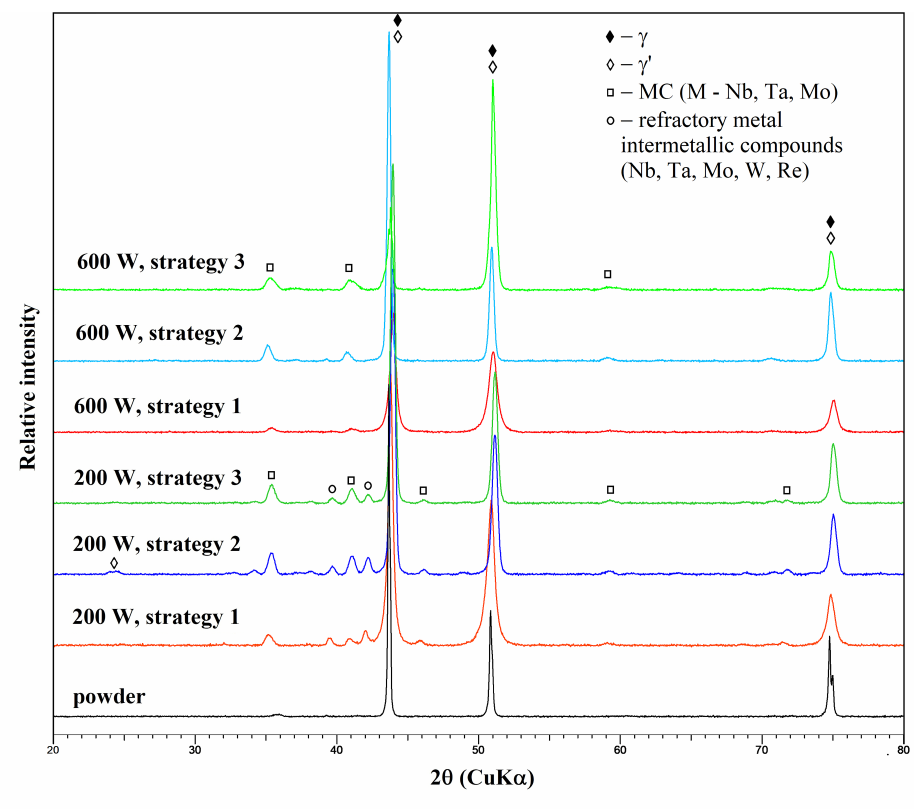
Figure 13. X-ray diffraction of powder and thin wall